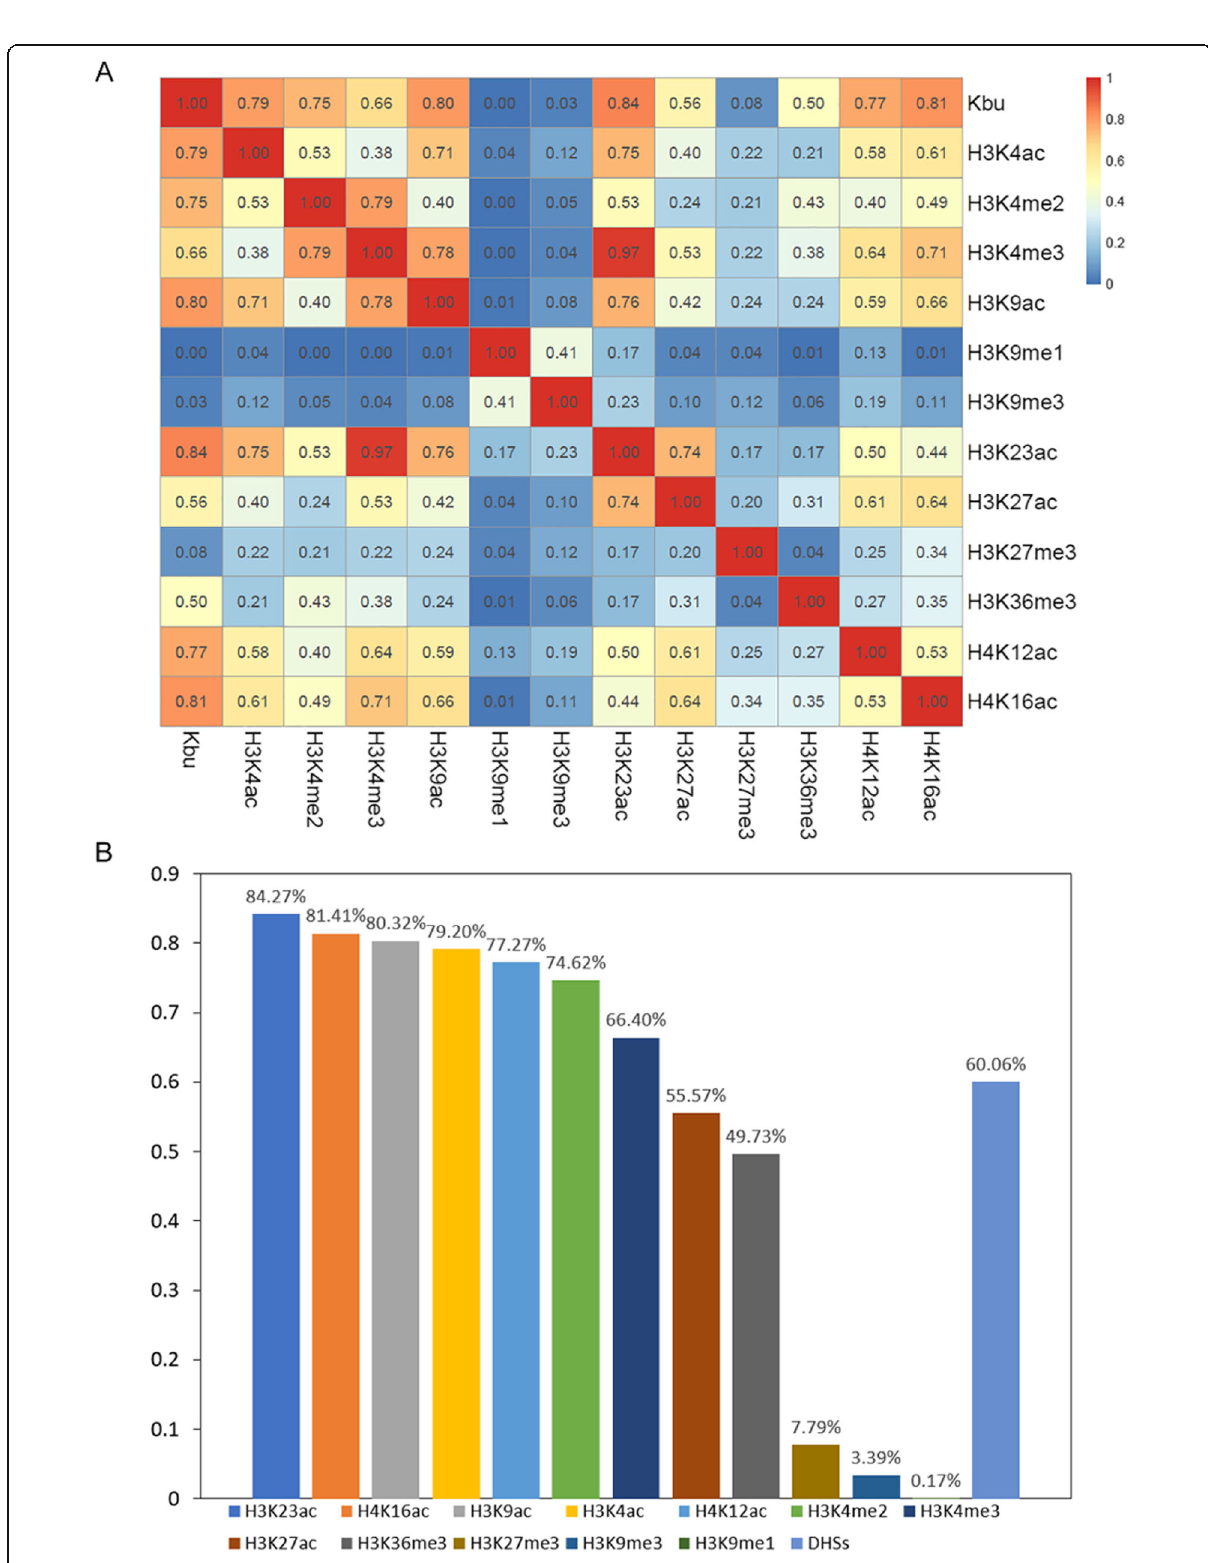
Fig. 4 The percentage of histone Kbu-enriched regions that overlap with regions enriched with 12 other histone modifications. a Heatmap b